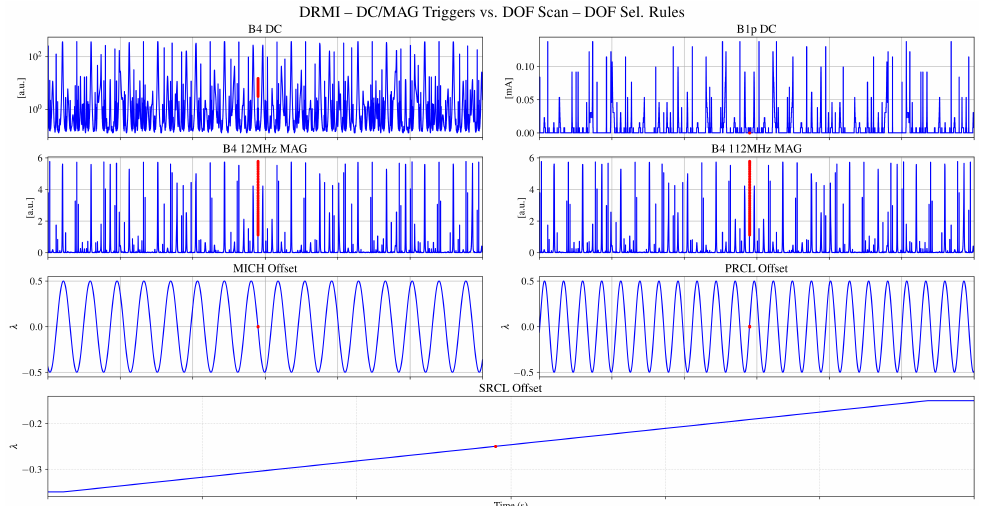
Figure 5. DRMI triggers: determination of the signals with respect to the DOF working point. This figure (shared x axis among subplots) represents a scan of the three DRMI DOFs, where it is known where the good working point is; in this way, it is possible to determine the value that signals of interest have in such point. During the study, a larger set of signals to be tested has been used to determine the best triggers; in this plot, only the most relevant signals are